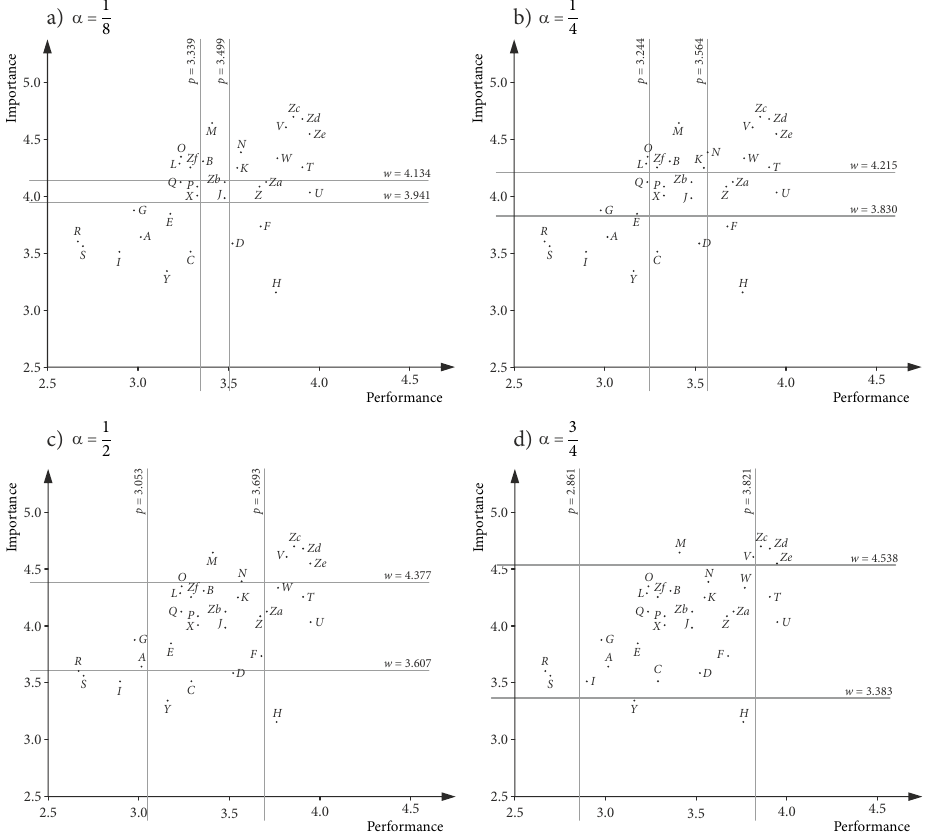
Figure 9. Nine categories for different confidence values (from a to d) (source: Lee et al., 2020 The vast majority of attributes are in the Grey zone and only on three green practices, Zc , Zd and Ze (Figure 9d) an unambiguous decision (of Competitive strength ) can be formulated.